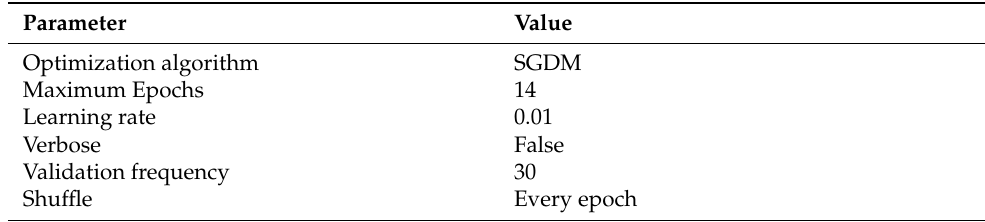
Table 2. Parameters of all transfer learning architectures.